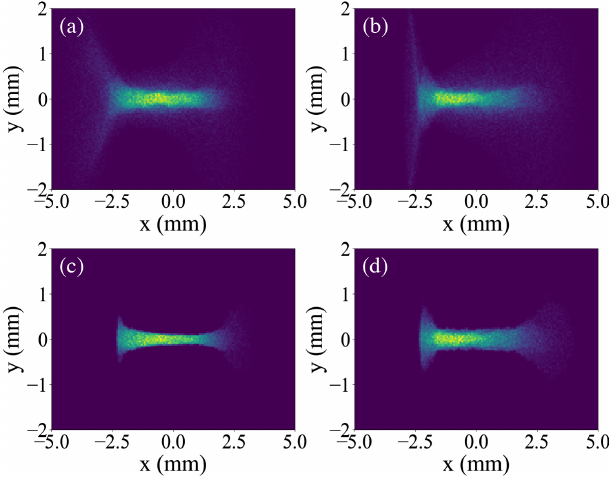
14. Beam images (a),(b) before and (c),(d) after the mask. (a) and (c) correspond to the Gaussian laser profile case in Fig. 10. (b) and (d) correspond to the shaped laser profile